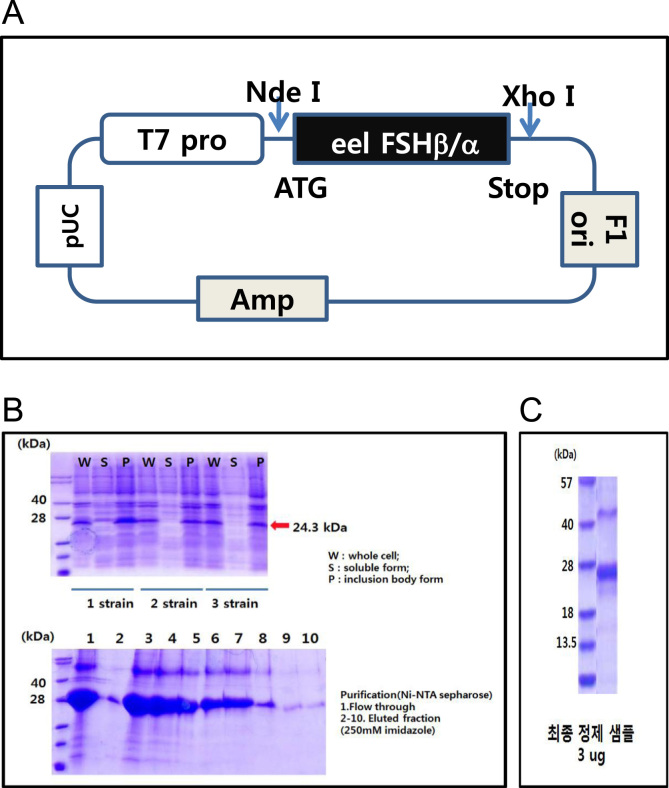
Construction of eel FSHβ/α expression vector and expression of rec-FSHβ/α in E. coli. (A) Construction of rec-tethered eel FSHβ/α cDNA by using overlapping PCR. The expression vector was subcloned into pRSET under the T7 promoter (designated as pRSET-eel FSHβ/α). (B) The pRSET vector was transformed into E. coli. After culture, whole-cell, soluble, and inclusion-body fractions were subjected to SDS-PAGE. One strain was cultivated in large-volume cultures and the protein was purified using Ni-NTA Sepharose column chromatography.